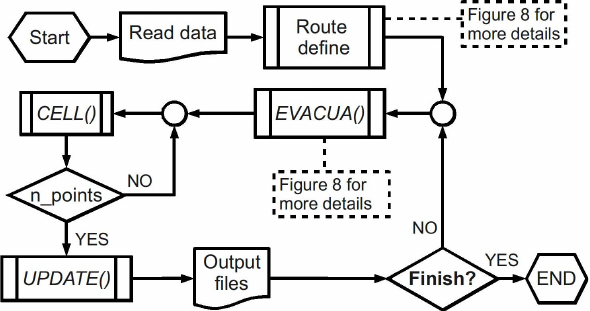
Fig. 7. Operating block diagram of VSEM. The program reads the input data and calculates the evacuation routes. From the calculated routes, each object p-road knows where to evacuate. Then, VSEM starts the simulation of the evacuation controlled by the EVACU- ATE() function. All computing procedures are performed by the CELL() and UPDATE() functions. The simulation ends when ev- eryone is evacuated or when there are no more arrivals at the check point during a time period or when the double evacuation time elapses without the occurrence of new arrivals at the check point.